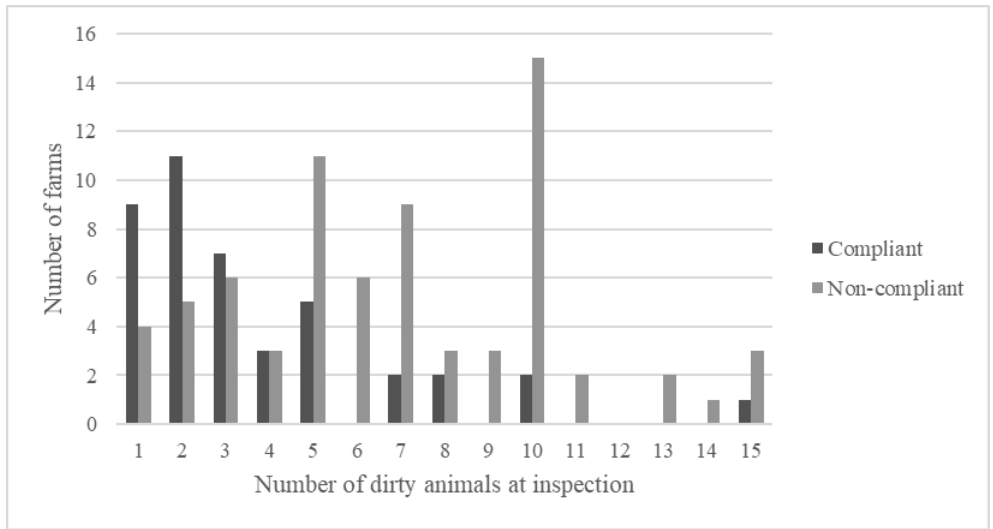
Figure 2. Assessments of compliance with Swedish animal welfare legislation on animal cleanliness during animal welfare inspections on 115 farms where up to 15 animals were found to be not clean enough.